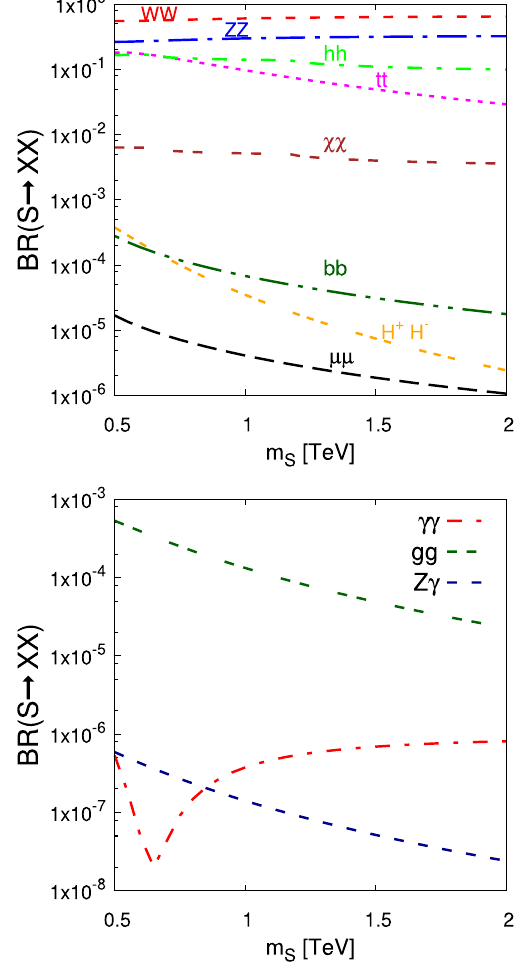
Fig. 5 Branching ratios of scalar S as a function of its mass. Top: tree-level decays; bottom: one-loop level decays